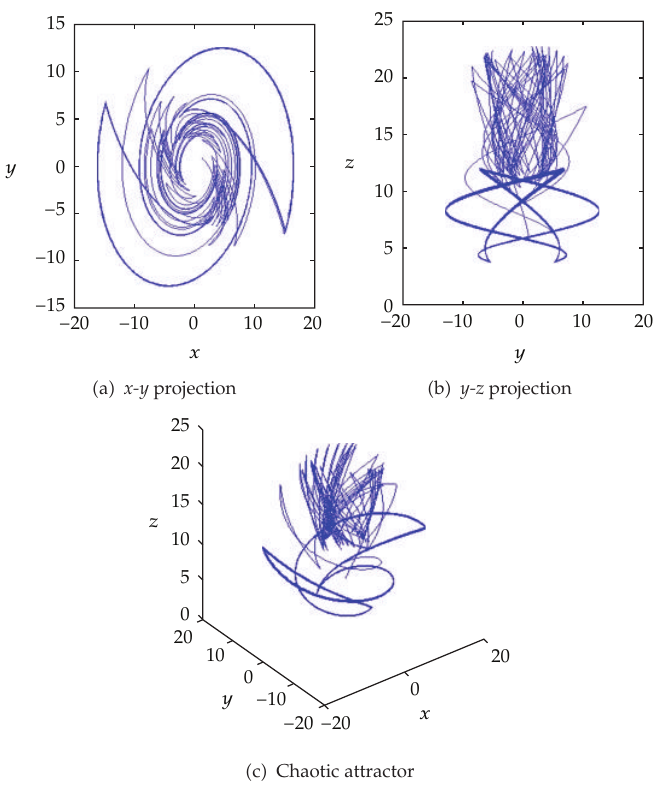
Figure 9: Chaotic attractor generated by G 1 (cid:7) 40, G 2 (cid:7)